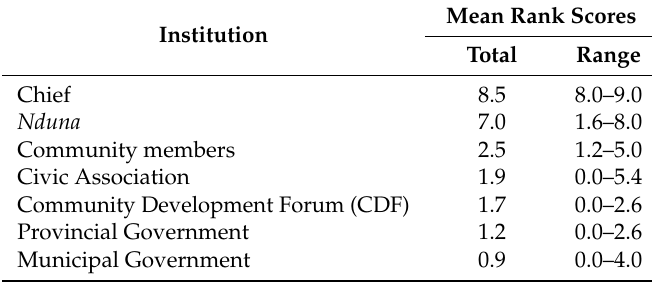
Table 4. Mean rank scores of local institutions with regard to their importance in firewood regulation, as perceived by community focus groups ( n = 30). 9.0 is highest possible